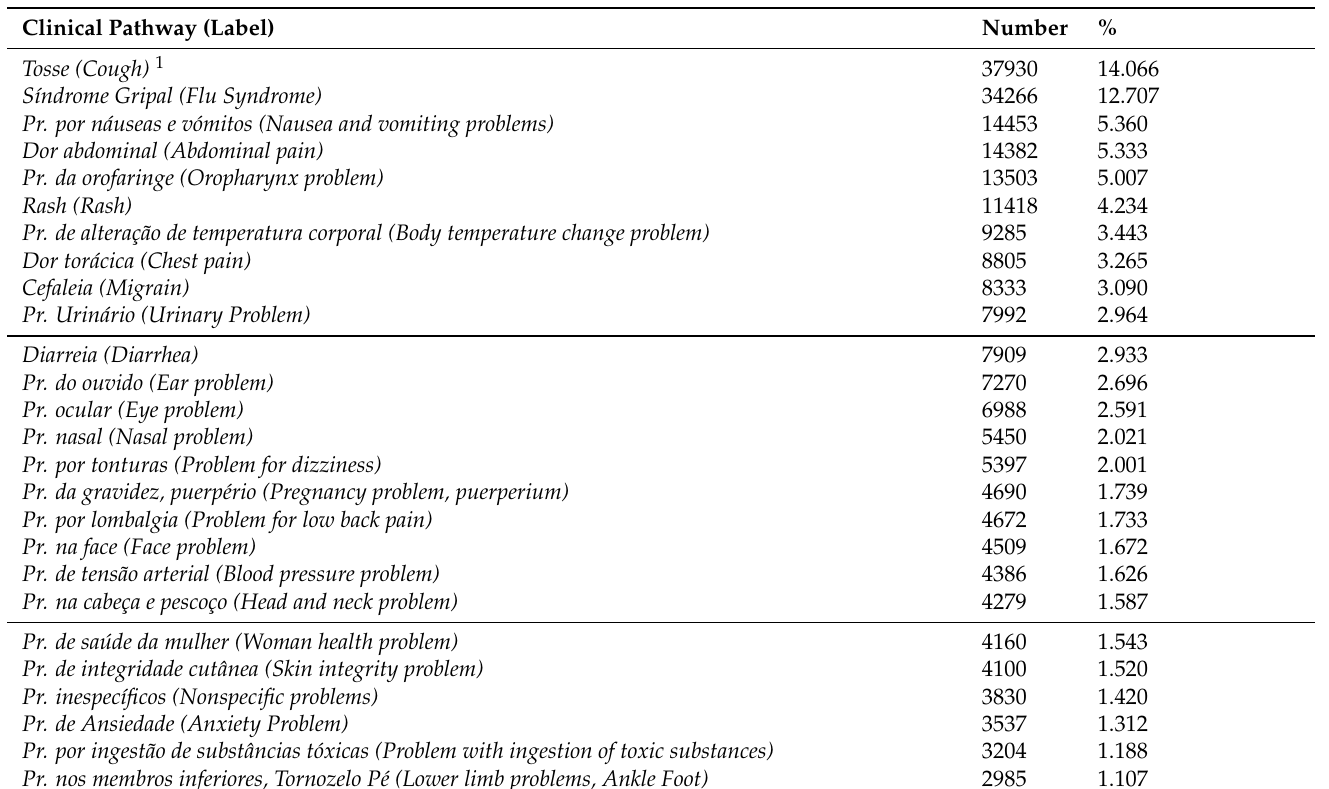
Table A1. The 52 clinical pathways within the dataset collected by the SNS24 phone-line from January to March 2018 (sorted by the number of occurrences). The label is reported in the original language Portuguese and